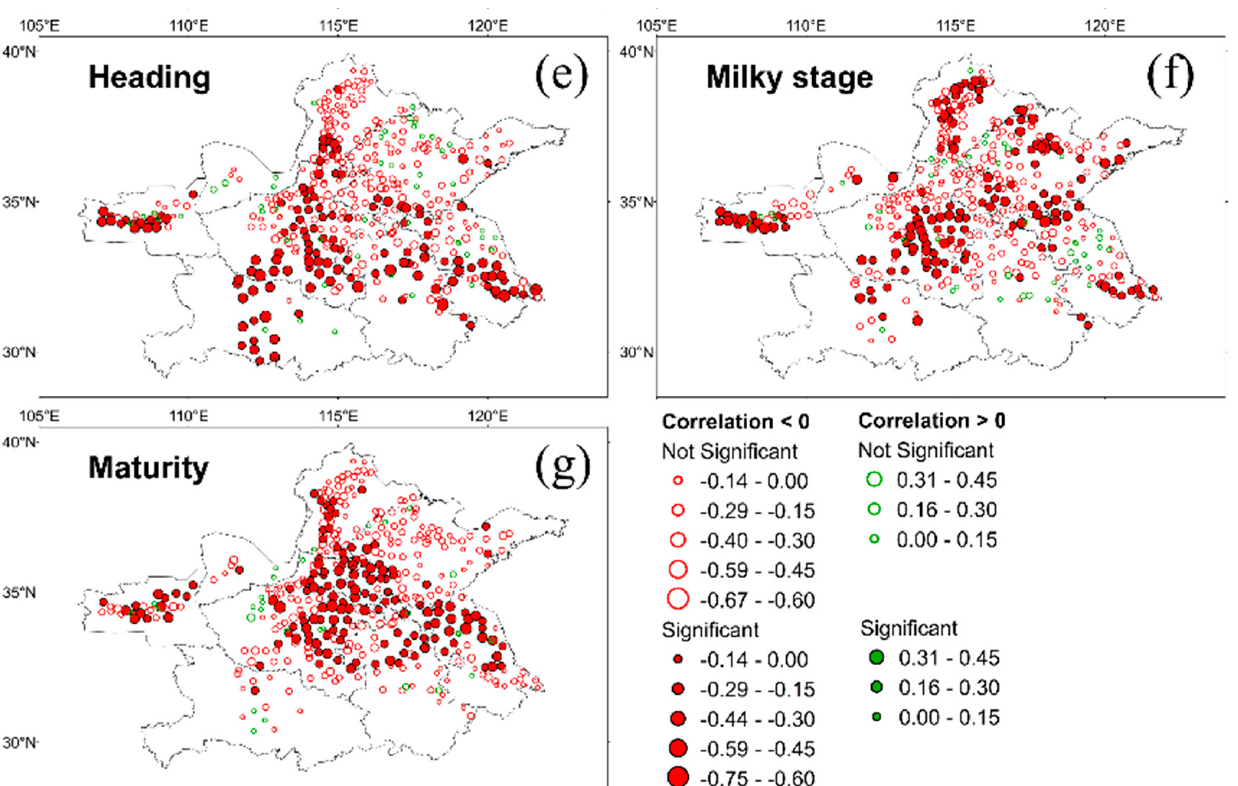
Figure 9. Correlation between phenological dates and corresponding preseason temperature from 1981 to 2016. Red circles represent negative correlations, and green circles represent positive correlations. Hollow circles indicate statistically insignificant correlations (P > 0.05), while solid circles indicate statistically significant correlations (P < 0.05). ( a ) represents correlation for emergence, ( b ) represents correlation for tillering, ( c ) represents correlation for green-up onset, ( d ) represents correlation for jointing, ( e ) represents correlation for heading, ( f ) represents correlation for milky stage, and ( g ) represents correlation for maturity, respectively.